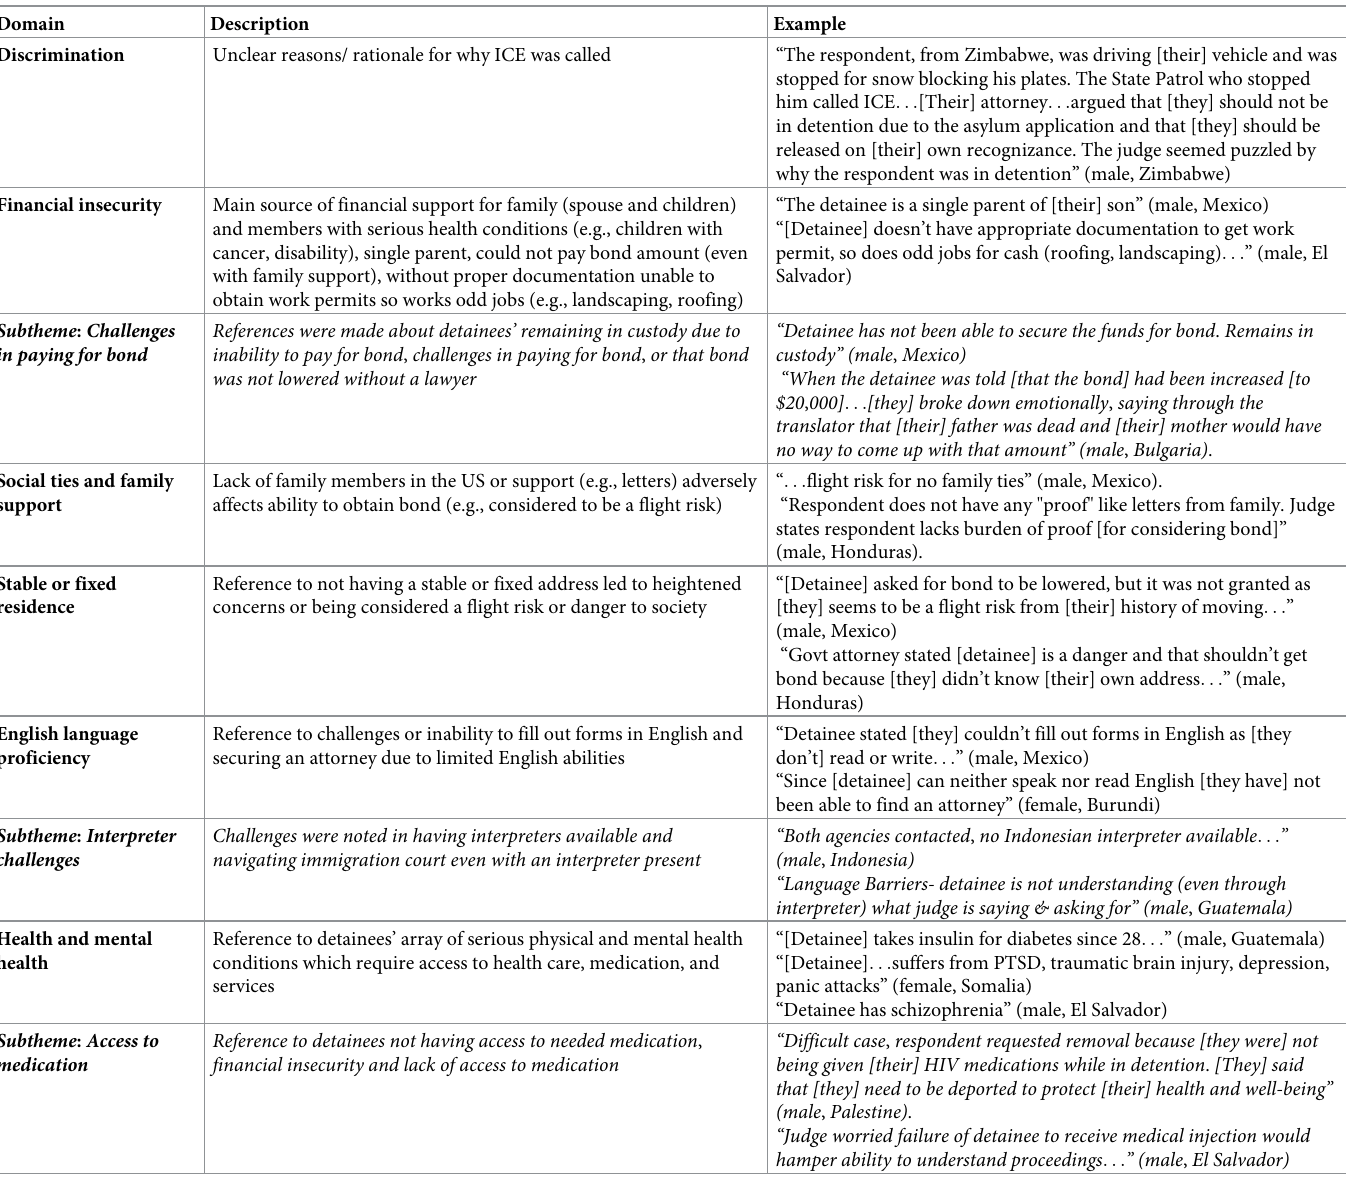
Table 1. Description and examples of perceived structural vulnerability domains.